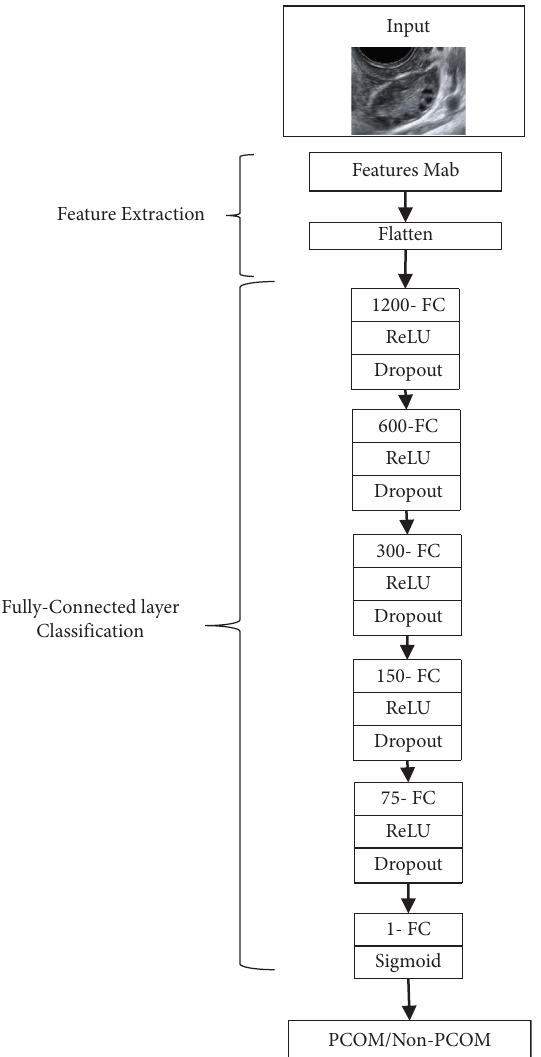
Figure 6: Structure of the fully connected layers in the network